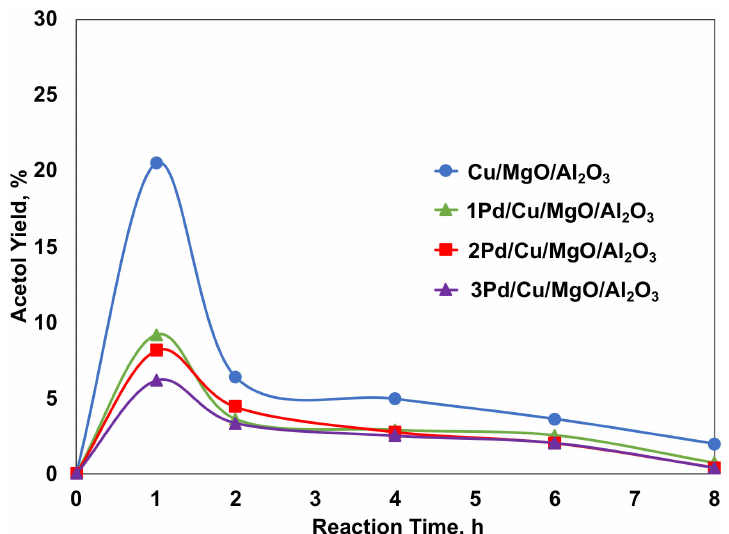
Figure 5. Effect of Pd loading over the reaction time on acetol yield. Conditions: 220 ◦ C, 15 bar N 2 , 40 wt% glycerol, water/methanol (molar) = 1.2, 7 wt% catalyst, 500RPM, 8 h, Cu/Mg/Al (molar) = 22.5/67.5/10, 40 wt%